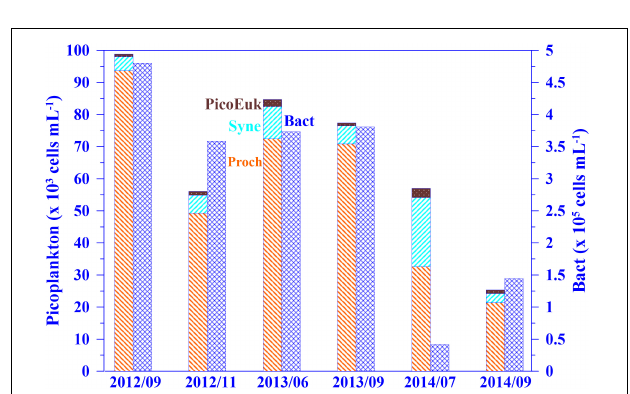
FIGURE 7 | The depth-integrated abundances of heterotrophic bacteria (Bact; × 10 5 cells mL − 1 ) and autotrophic picoplankton ( × 10 3 cells mL − 1 ), e.g., Prochlorococcus (Proch), Synechococcus (Syne), and picoeukaryotes (PicoEuk), for the upper 100 m depth over each sampling